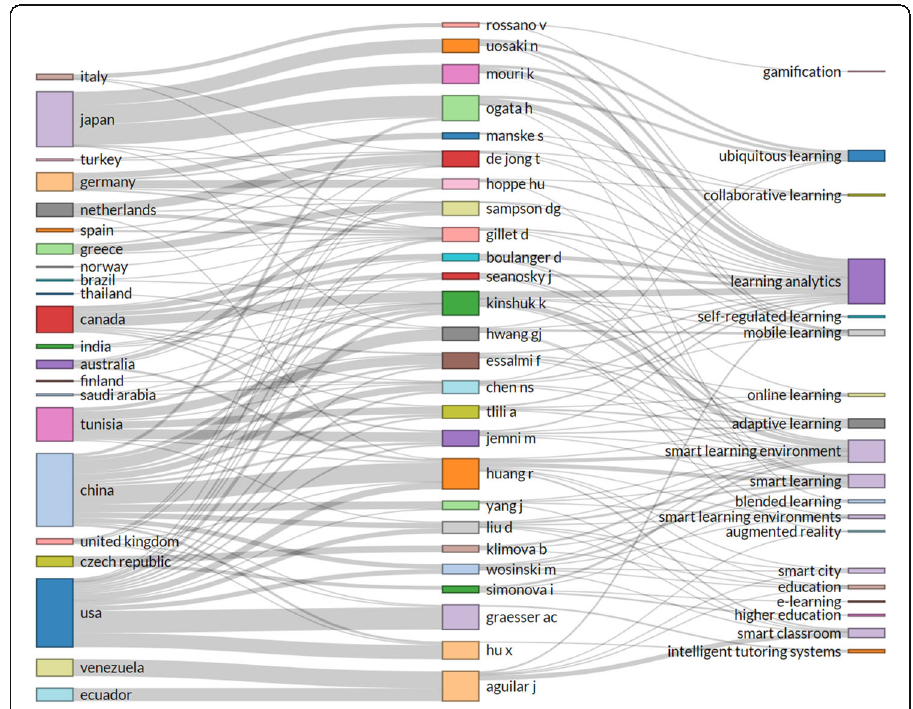
Fig. 5 A three-field plot of countries, authors, and themes of smart learning environments: The emphasis is placed on the height of each box and thickness of the connecting lines; the taller the box, the more significant; and the thicker the lines ’ correlation, the more information or volume of work was